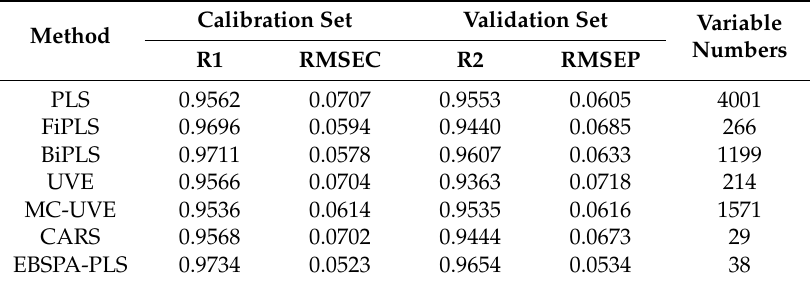
Table 5. Comparison of model performances.